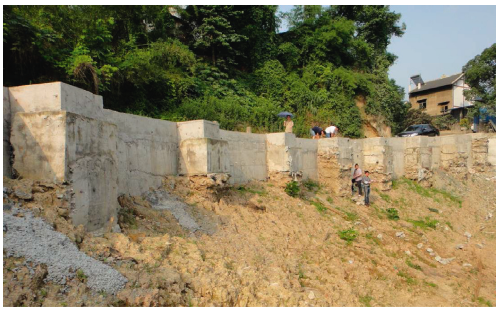
Figure 18: Pile plate retaining wall in field.